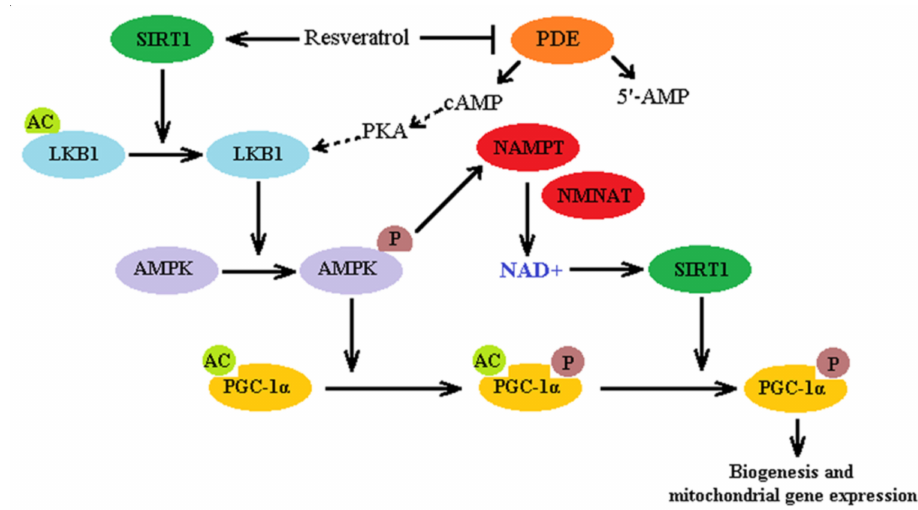
Figure 4. Resveratrol and putative signaling pathways involving SIRT1, AMPK and PDE. Sirtuin 1 (SIRT1), AMP-activated protein kinase (AMPK), Phosphodiesterase (PDE), cyclic AMP(cAMP), Protein kinase A (PKA), Liver kinase B1 (LKB1), PPAR gamma co-activator 1 alpha (PGC-1 α